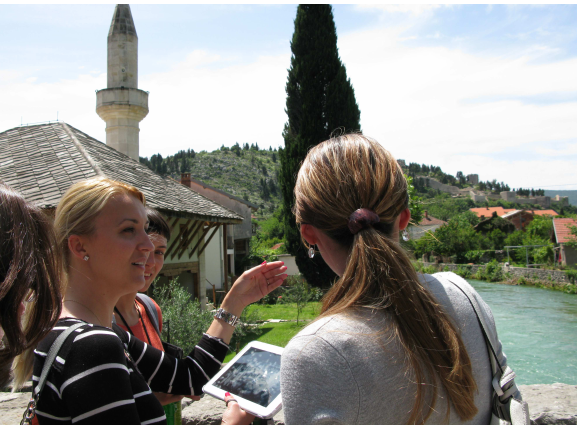
Figure 3 Testing the digital smartphone / tablet computer guides on site in Stolac. A web version is also available as well as on a large table computer installed in the school